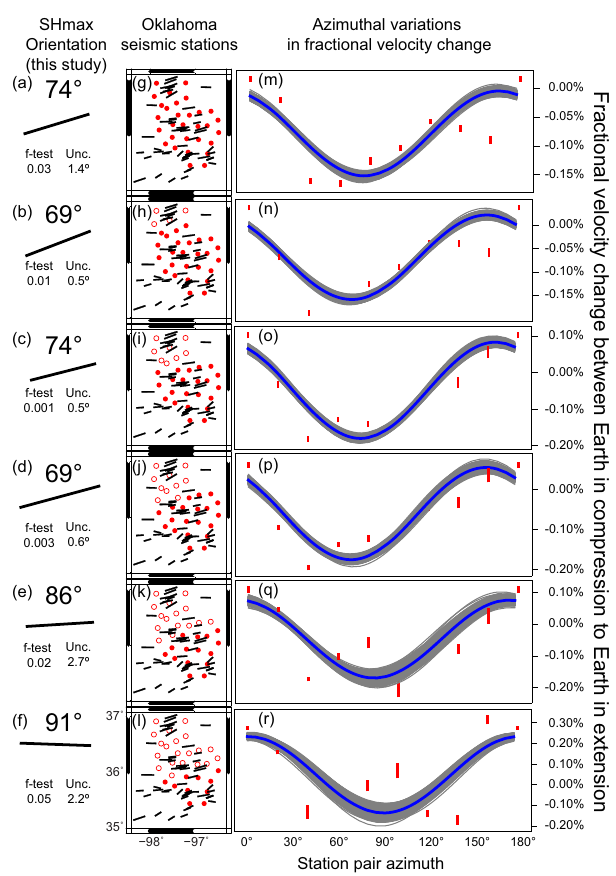
Fig. 4 Oklahoma results. For Oklahoma, we show the seismic stations and azimuthal dependence of the fractional change in velocity from when tidal strains were in compression to when tidal strains were in extension. In a – f , we show the S Hmax results from this study with directional indicator, the results of an f test comparing the sine model to a uniform model, and the uncertainty in the azimuthal prediction. In g – l , the short black lines indicate the direction of S Hmax from the 2016 release of the World Stress Map (WSM) 25 using conventional methods. Classes A, B, and C are WSM quality ratings that are identi fi ed according to length. Solid red stations are used to calculate fractional velocity changes shown adjacent m – r . Vertical red bars represent 1-sigma standard deviation uncertainties in the azimuthal measurements. The blue curve is the average of 1000 realizations (gray lines) of the best- fi t sine function applying uncertainties in azimuthal measurements. The minimum value of the blue curve indicates the orientation of S Hmax